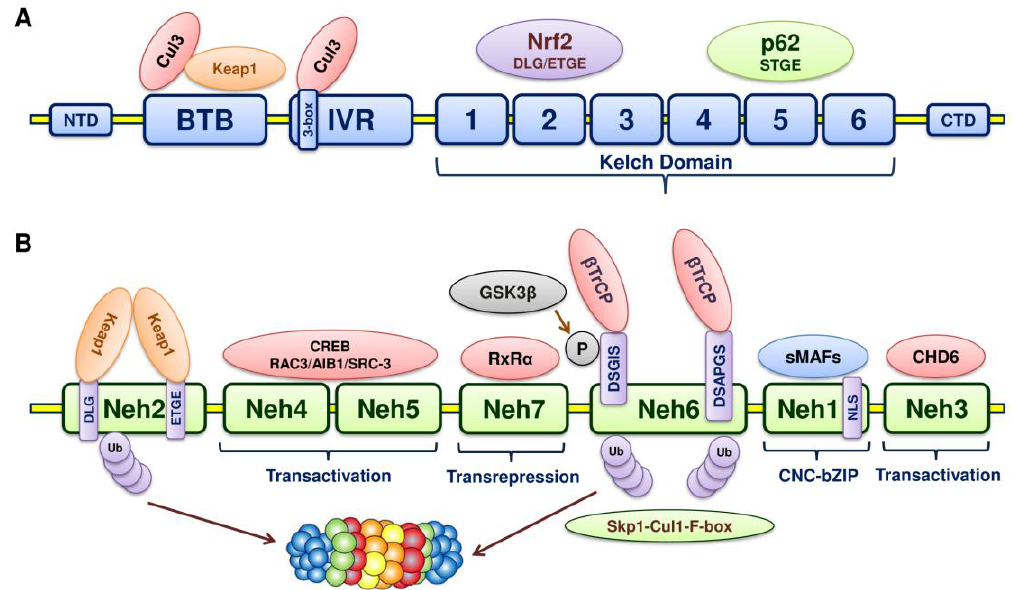
Figure 3. ( A ) Domain structure of Keap1. The BTB domain mediates homodimerization with another Keap1 and associates with Cul3. The IVR domain also mediates interaction with Cul3 and is a